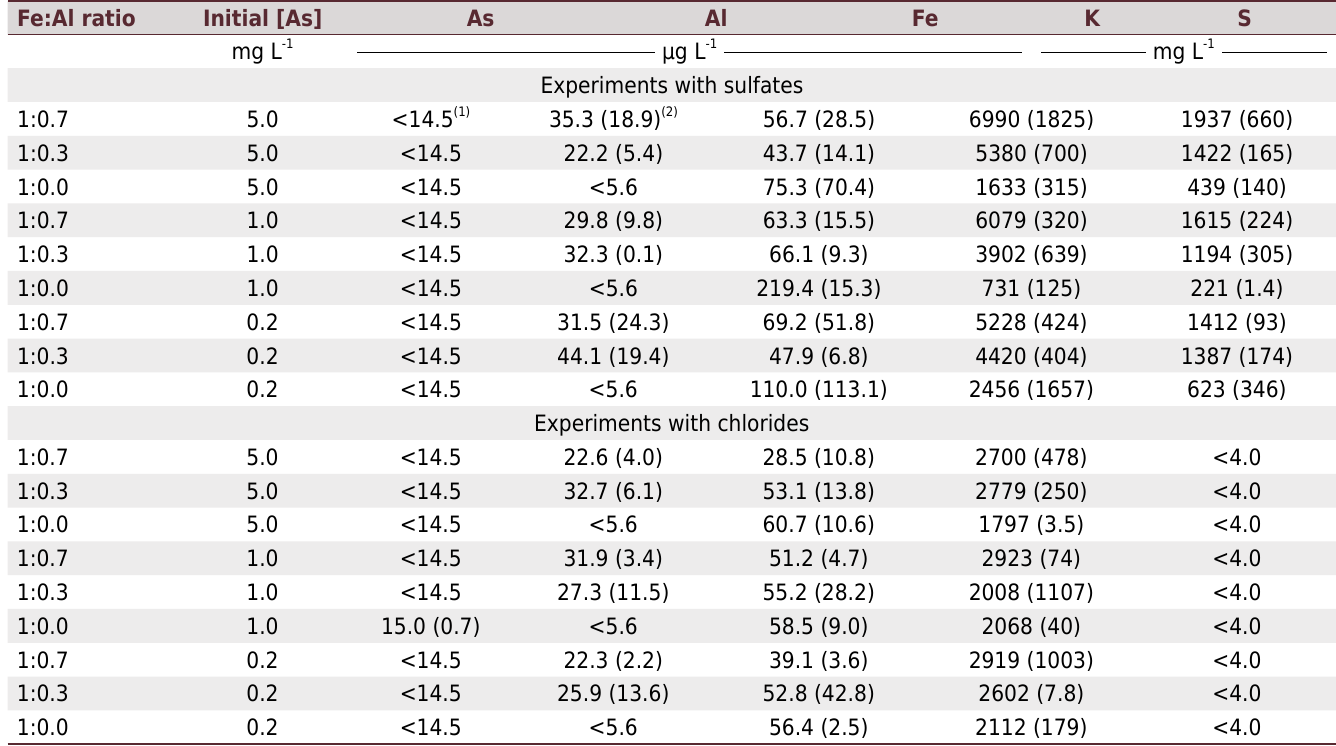
Table 5. Concentrations of As, Al, Fe, K, and S leached by the acetic acid solution after the TCLP test, quantified by ICP-OES Fe:Al ratio Initial [As]